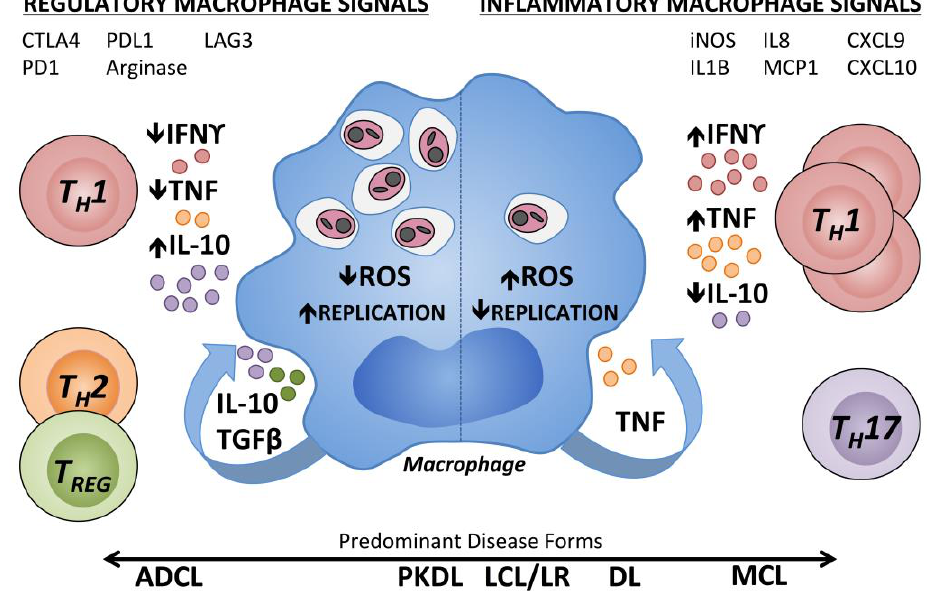
Figure 1. Immune regulation of human macrophages contributing to different pathologic states during Leishmania infection. Human macrophages parasitized by Leishmania spp. are subject to regulation by cytokines present within the skin at the infection site. Inflammatory Type 1 cytokines, IFN γ and TNF, can synergistically induce ROS production by macrophages, thereby inhibiting Leishmania replication within the phagolysosome. T H 17 cells are increased in inflammatory MCL lesions. Chemoattractant transcripts (IL8, MCP1, CXCL9, and CXCL10) and transcripts associated with classical (type 1) macrophage activation (iNOS, IL1 β ) have been measured in inflammatory CL lesions. In a regulatory environment (left), there are low levels of type 1 cytokines with lack of microbicidal effectors. T cell or macrophage-derived cytokines including type 2 cytokines, IL-10 and TGF β antagonize the effects of IFN γ and TNF, and enhanced polyamines can result in parasite proliferation. T REG cells can suppress the effects of IFN γ . Inhibitory receptors on CD4 + or CD8 + T cells (CTLA4, PD1, and LAG3) and their counter-ligands (CD80, CD86, and PDL1) are associated with T cell exhaustion. Arginase activity is associated with M2-type non-classical macrophage activation. IFN γ : Interferon γ ; TNF: Tumor necrosis factor; IL10: Interleukin 10; TGF β : Transforming growth factor β ; ROS: Reactive oxygen species; ADCL: Anergic diffuse cutaneous leishmaniasis; PKDL: Post Kala-Azar dermal leishmaniasis; LCL: Localized cutaneous leishmaniasis; LR: Leishmania recidivans; DL: Disseminated